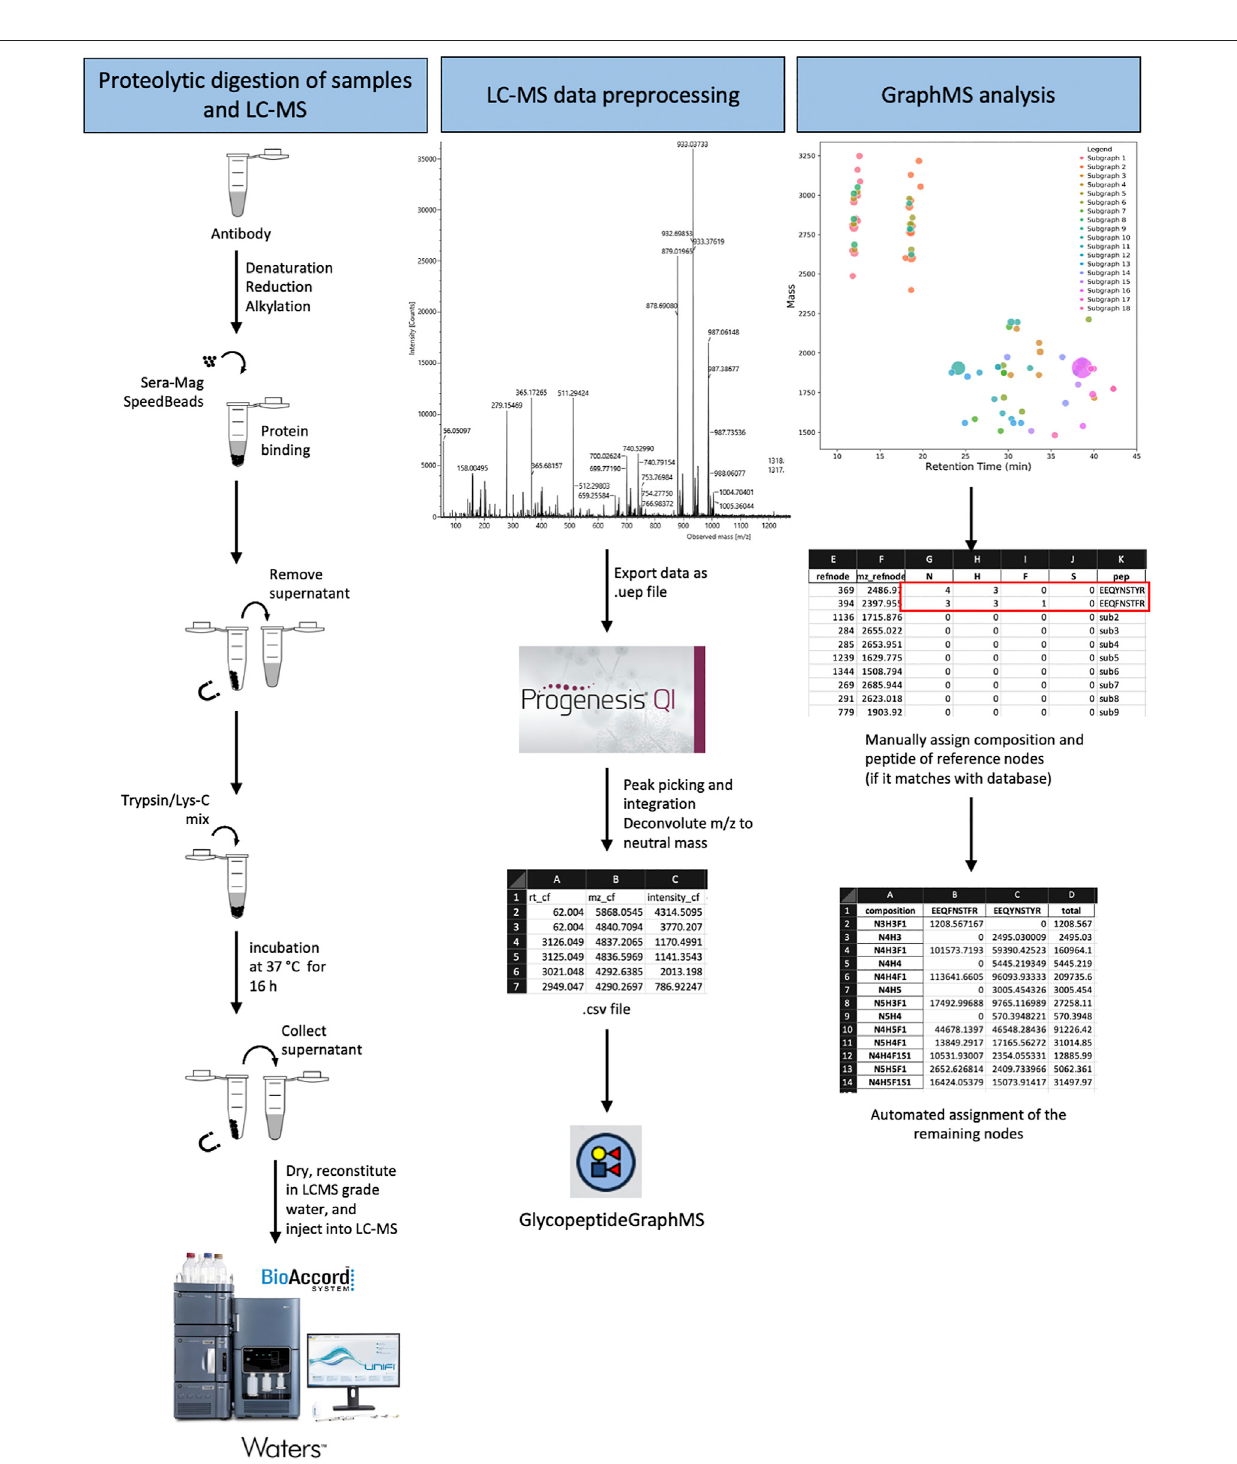
FIGURE 1 | Schematic illustration of the glycoproteomic analysis work fl ow using GraphMS on Waters BioAccord LC-MS system data.